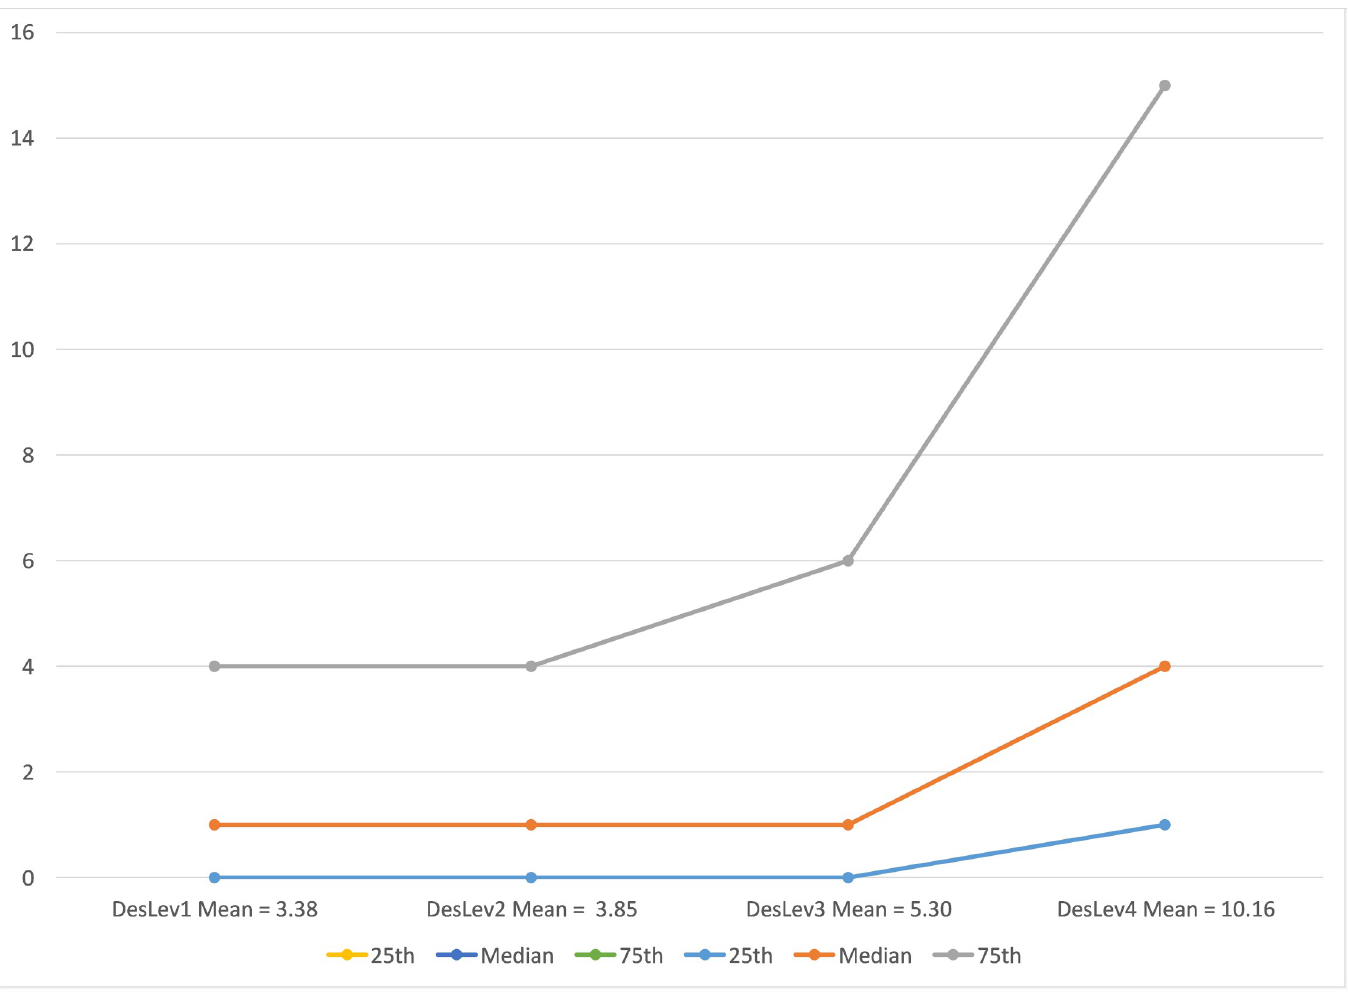
Fig 6. Number of high growth establishments in ZIP